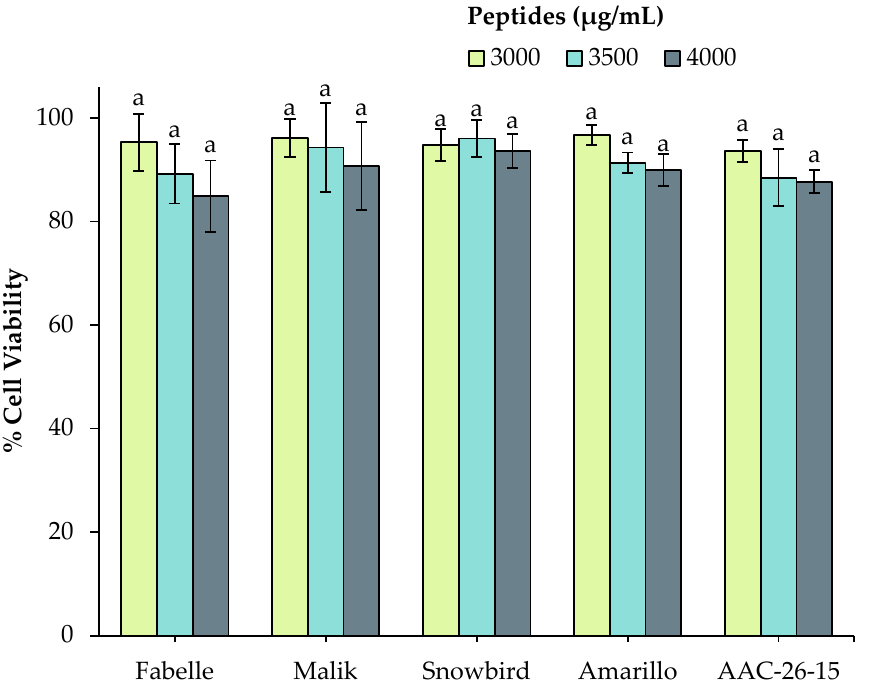
Figure 2. Impact of different concentrations (3000, 3500 and 4000 µ g peptides/mL) of 3 kDa permeate of legume digestates obtained in the optimized digestion conditions (AEBSF 1 mM, bile salt 10 mM, pancreatin and peptidase) on cell viability. Data are expressed as mean ± standard deviation and means without a common letter differ ( p < 0.05) as analyzed by two-way ANOVA and the Tukey’s test.